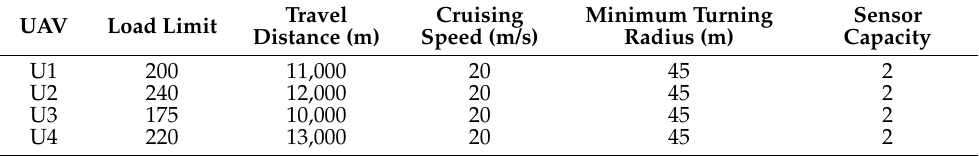
Table 3. UAVs attributes. Table 2. Sensors attributes.